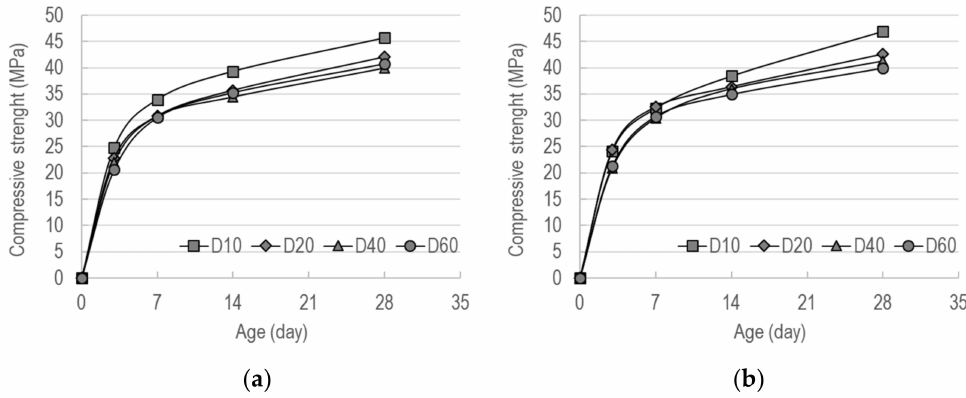
Figure 4. Compressive strength histories: ( a ) W170 mixtures and ( b ) W160 mixtures.